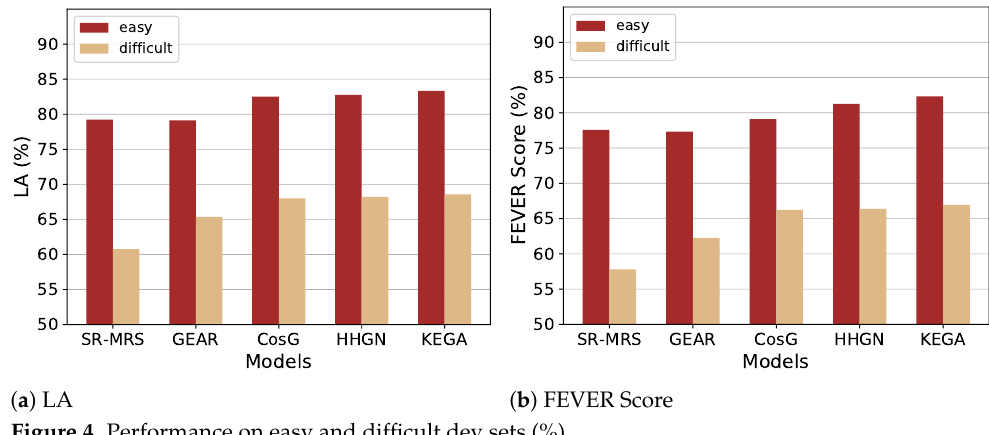
Figure 4. Performance on easy and difficult dev sets